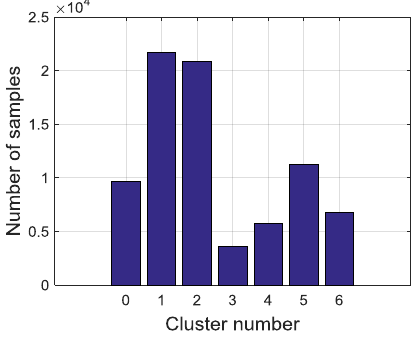
Figure 6. Distribution on total symbol data.